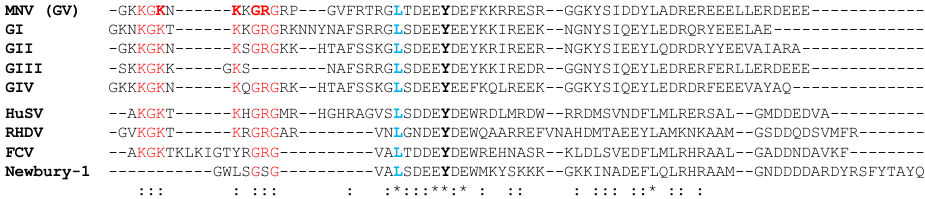
Figure 4. Alignment of the first 62 amino acids of VPg from different norovirus genogroups and representative members of the Caliciviridae family. An asterisk (*) indicates identical residues. A colon (:) indicates residues that are identical in >50% of sequences. Conserved amino acids of the N-terminal region are shown in red, and in bold red are MNV VPg residues used for point mutations. The tyrosine residue (Y) corresponding to Y26 of MNV VPg is shown in bold. A conserved leucine residue used as the junction point for the construction of chimeric VPg proteins is shown in blue. The represented genogroups are GI Norwalk virus VPg, GII Sydney 2012 VPg, GIII Jena virus VPg, and GIV Lake Macquarie VPg.